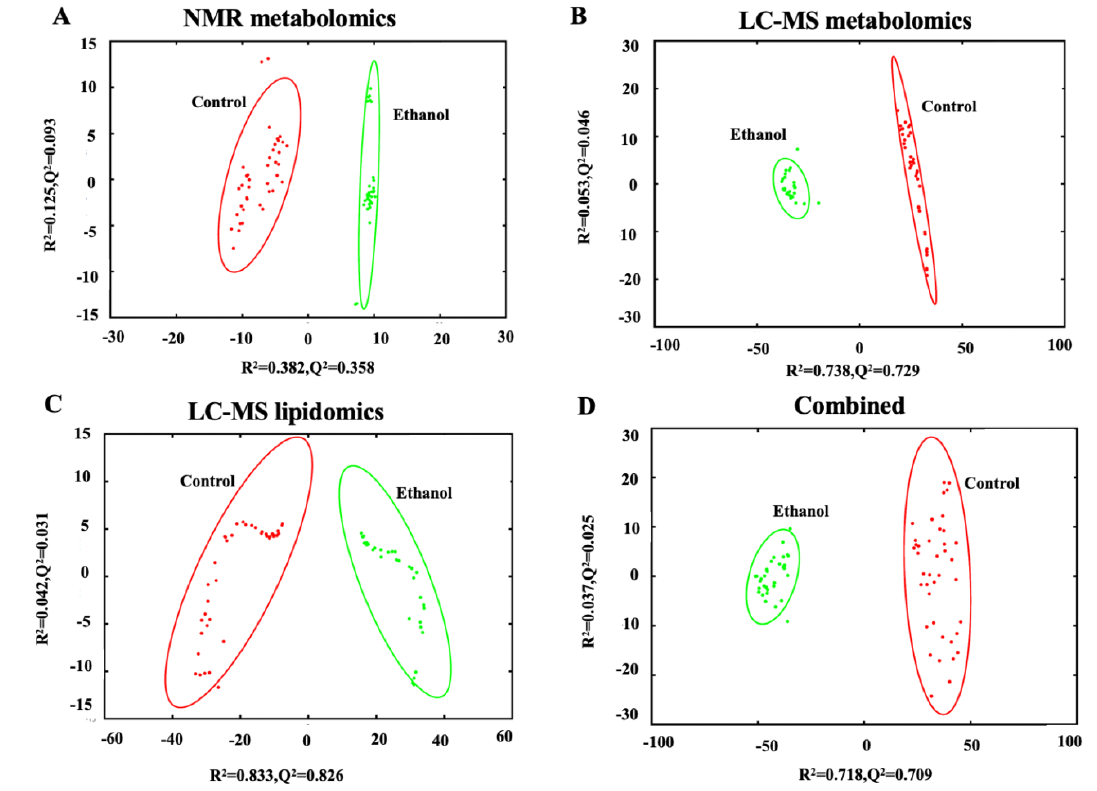
Figure 2. PCA scores plot generated from ( A ) 1D 1 H NMR metabolomics data set ( R 2 0.507, Q 2 0.451), ( B ) LC-MS metabolomics data set ( R 2 0.791, Q 2 0.775), ( C ) LC-MS lipidomics data set ( R 2 0.875, Q 2 0.857), and ( D ) the combined omics data set ( R 2 0.755, Q 2 0.734) comparing control (red) to ethanol (green) treatment of rat hepatocytes. The ellipses represent a 95% confidence limit of the normal distribution of each cluster.